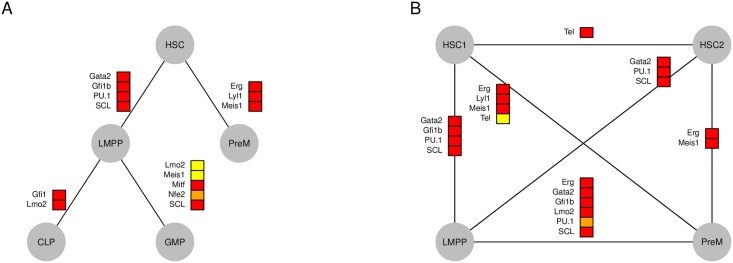
Most significant kinetic parameters variations during hematopoiesis.This figure illustrates kinetic parameter change predictions that are consistent across all six methods illustrated in the key of Fig 5– in other words, this is the intersection of BIC, MP, and the subset methods, as applied to both pruned and un-pruned datasets. Just as in Fig 5, red boxes designate that Kon varies, yellow boxes designate that Kt varies and orange boxes designate that both parameters change. A positive/negative signifies that gene expression increases/decreases along the line (top to bottom; or in the case of horizontal lines left to right). (A) The most significant kinetic parameter changes are shown for the expected hematopoietic tree. (B) Based on the SABEC clustering analysis, it appeared as if there were two distinct HSC subpopulations– the differences between these two subpopulations and LMPP and PreM subpopulations were also calculated.